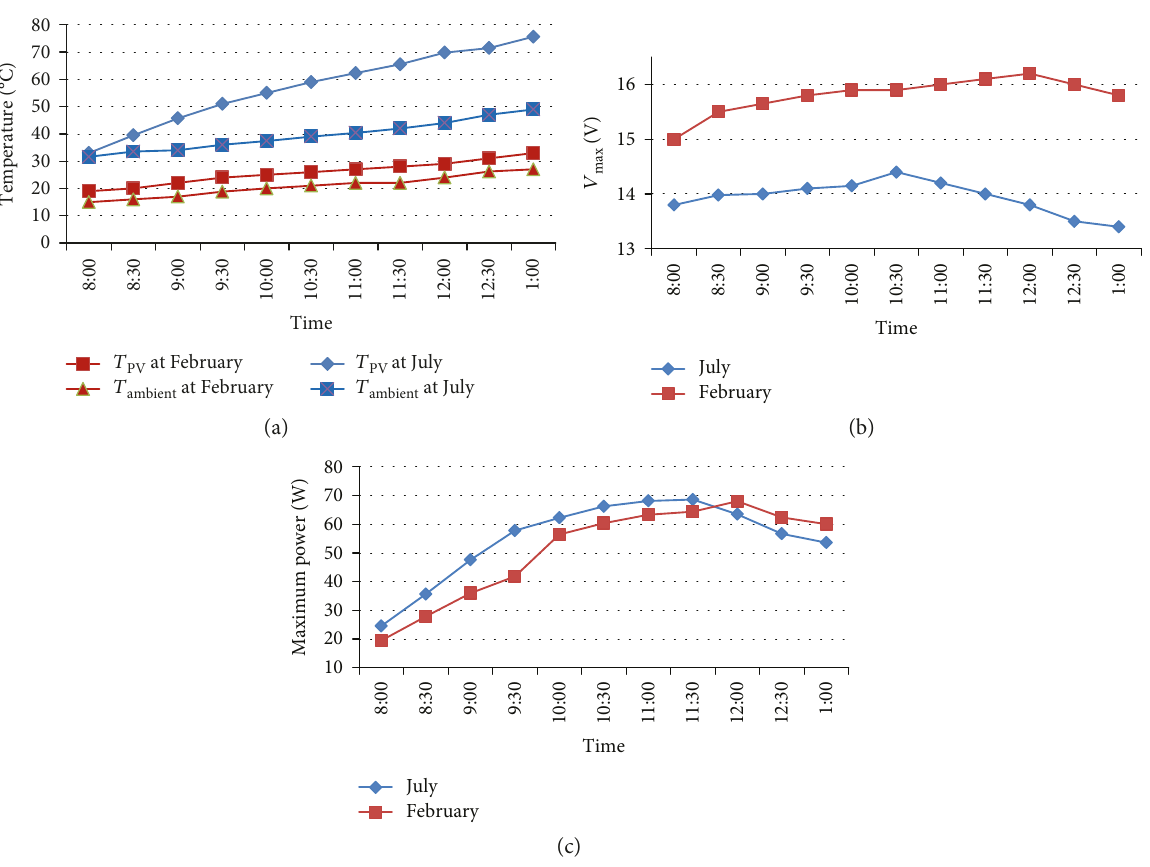
Figure 5: (a) Temperature variations at climatic conditions. (b) Comparison between the voltages at climatic conditions. (c) Comparison between the output powers at climatic